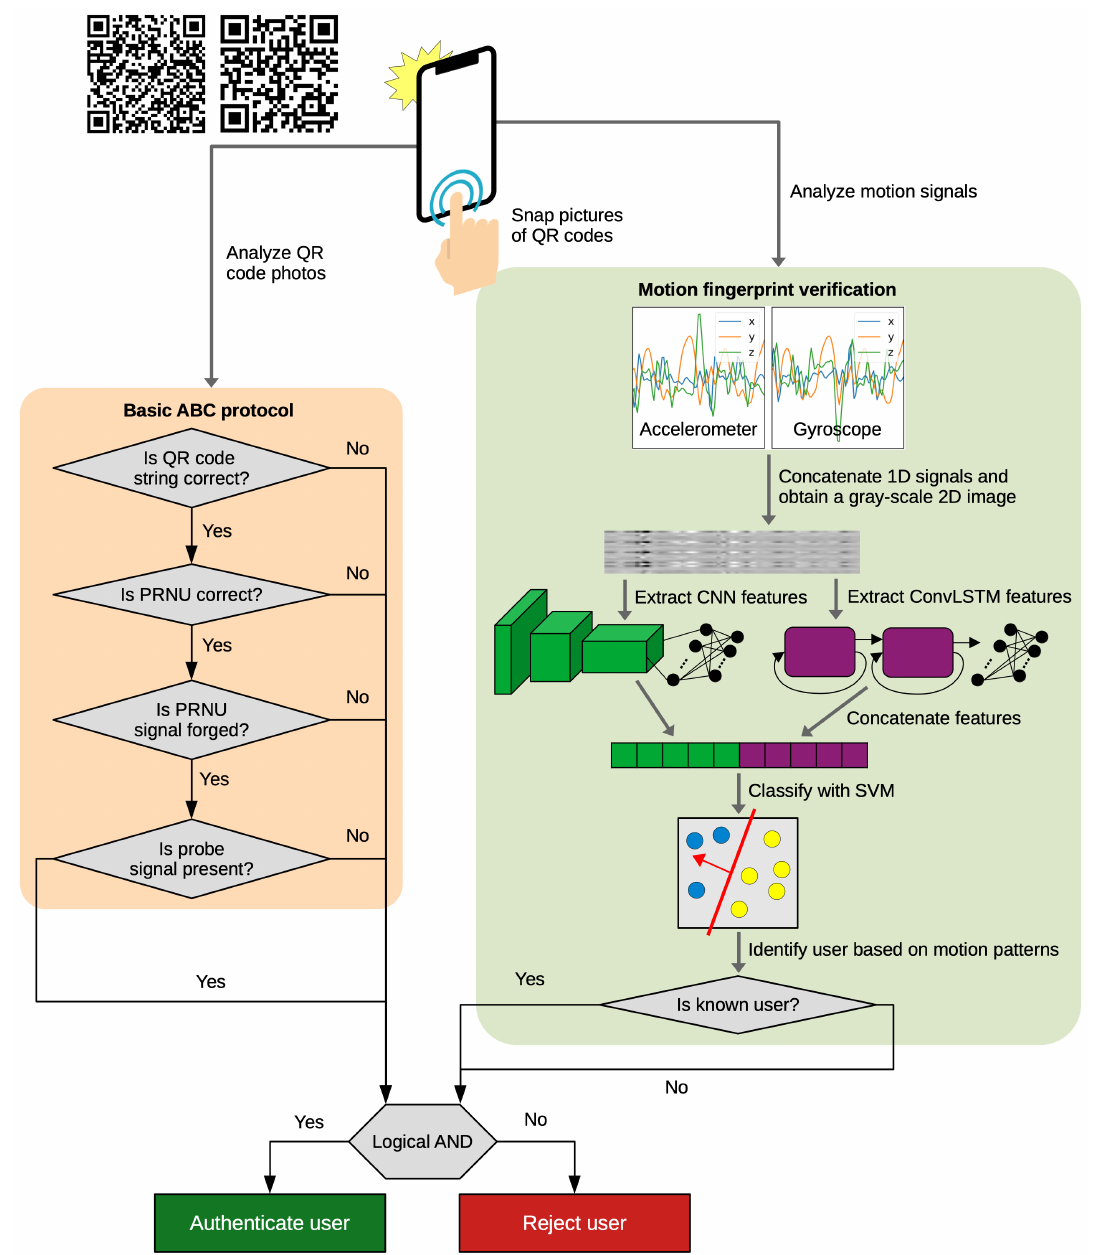
Figure 1. An overview of the proposed multi-modal ABC protocol. The basic ABC protocol is augmented with a deep learning system that analyzes the motion fingerprint. Best viewed in